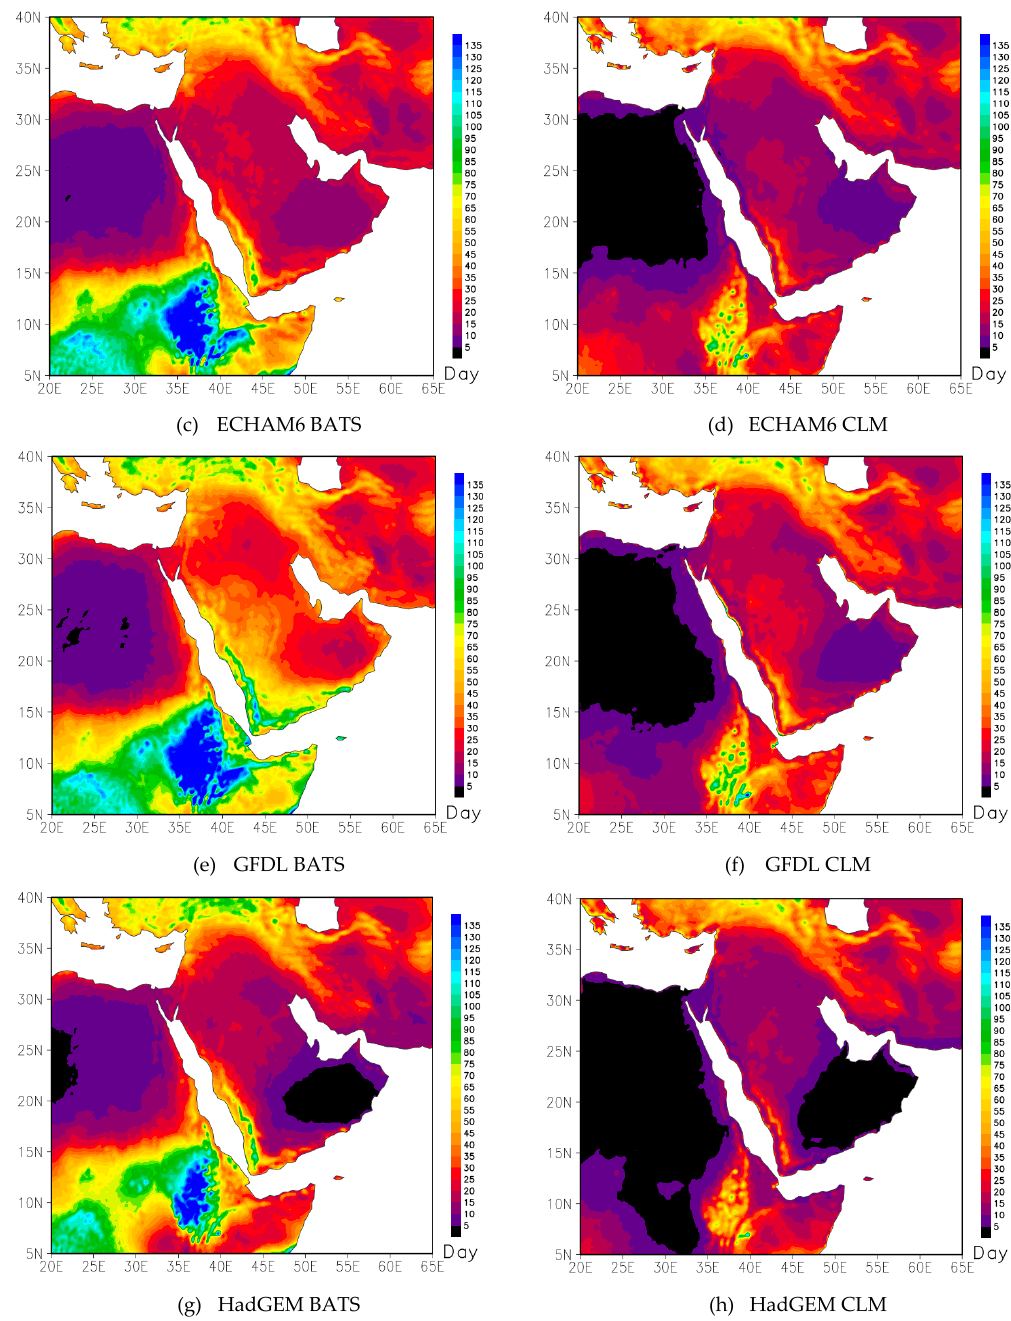
Figure 12. Spatial distribution of the annual number of annual consecutive wet days (CWD) for ( a ) ERA–Int BATS, ( b ) ERA–Int CLM, ( c ) ECHAM6 BATS, ( d ) ECHAM6 CLM, ( e ) GFDL BATS, ( f ) GFDL CLM, ( g ) HadGEM BATS, and ( h ) HadGEM CLM averaged over the period 1986–2005. Consecutive dry days (CDD): This index is calculated from daily precipitation amounts from the ERA–Int and CMIP5 models (Figure 13). The absolute value of CDD can reach about 350 days over the Arabian Peninsula, reflecting the arid condition of the region. The CLM simulations produce more consecutive dry days than the BATS simulations, and GFDL produces the fewest CDD compared to other simulations and ERA–Int. The distribution of CDD is similar to the distribution of CWD over the